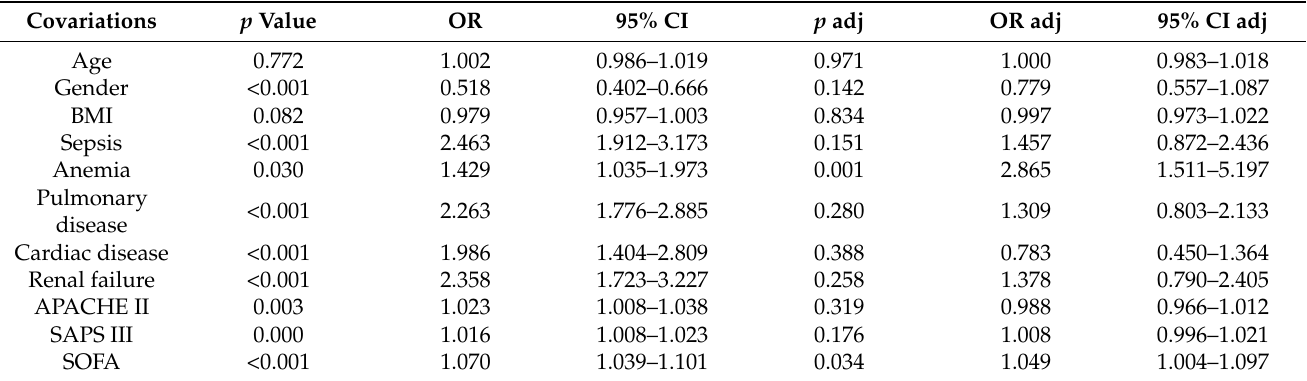
Table 4. Univariate and multiple variation analysis of anemia in NOAF